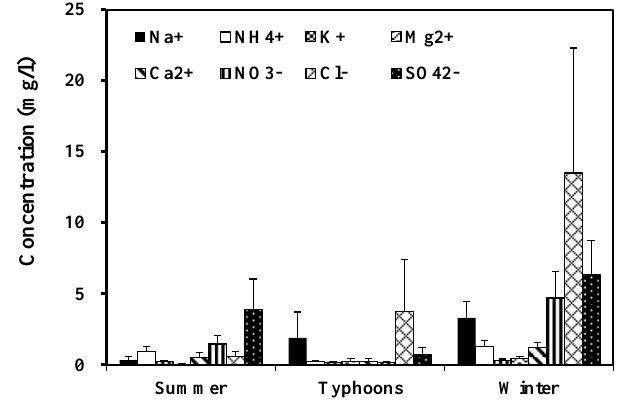
Figure 6. Mean concentration of major ions in rainwater sam- ples during summer (July–September), typhoons, and winter (November–December).